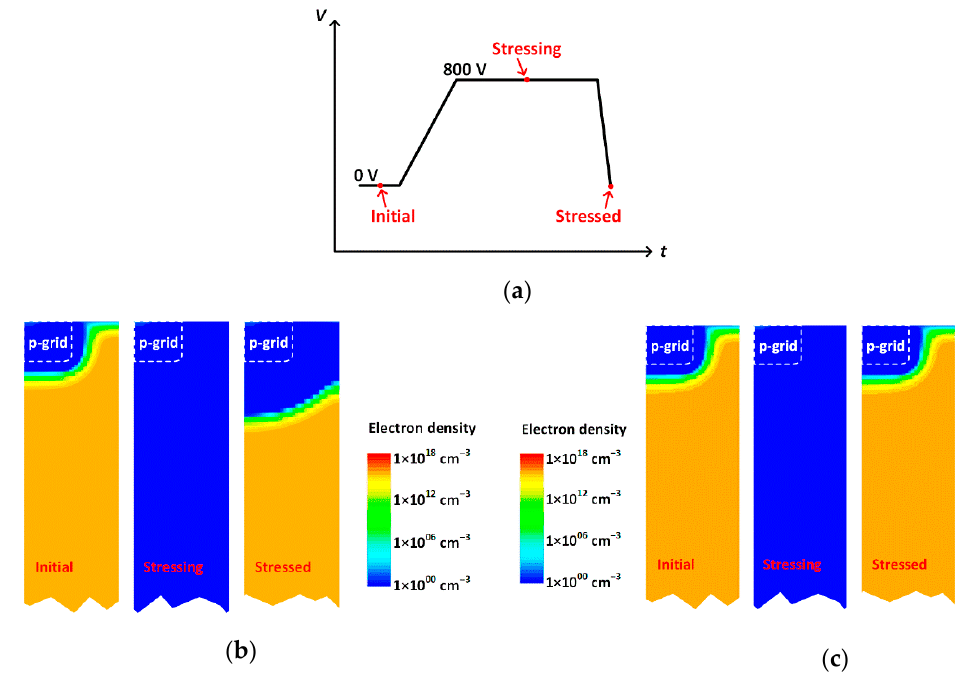
Figure 5. ( a ) Waveform of the voltage on the SiC JBS diode with a Schottky contact to p-grid for dynamic simulations. The electron distribution in the SiC JBS diodes with ( b ) Schottky contact to p-grids and ( c ) Ohmic contact to p-grids. The time used to turn the device from the stressing state to stressed state under 0 V is 1 µs.